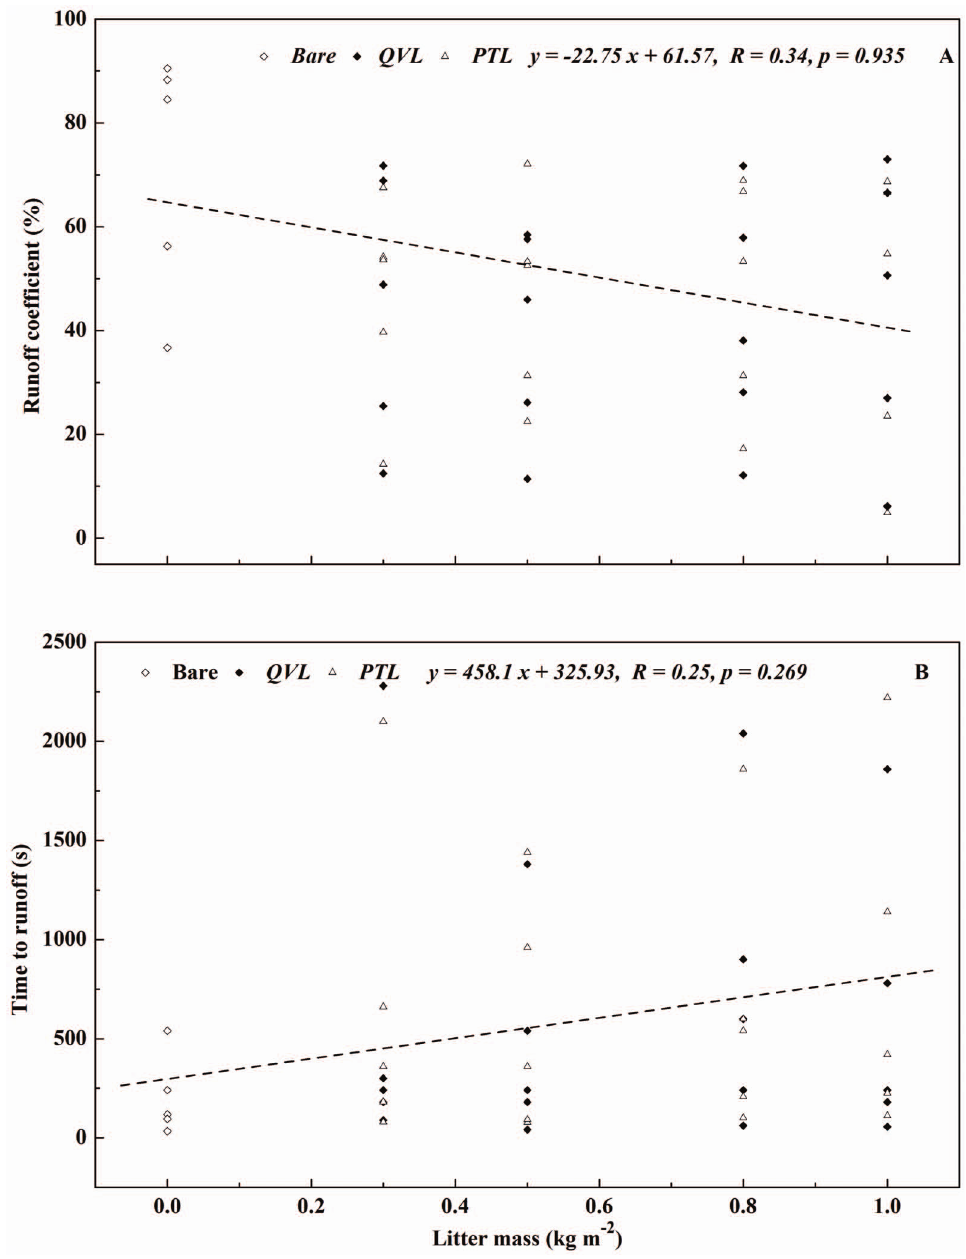
Figure 4. Runoff coefficient and time to runoff versus litter mass for bare-soil plots (open diamonds), Quercusvariabilis litter (closed diamonds), and Pinustabulaeformis litter (open triangles) for five rainfall intensities.